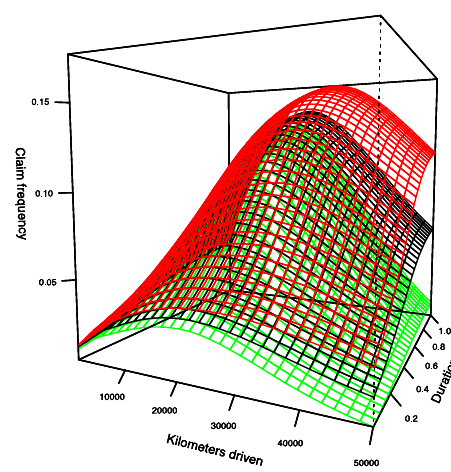
Figure 10. Model 2—Predictions surface (angle 2).